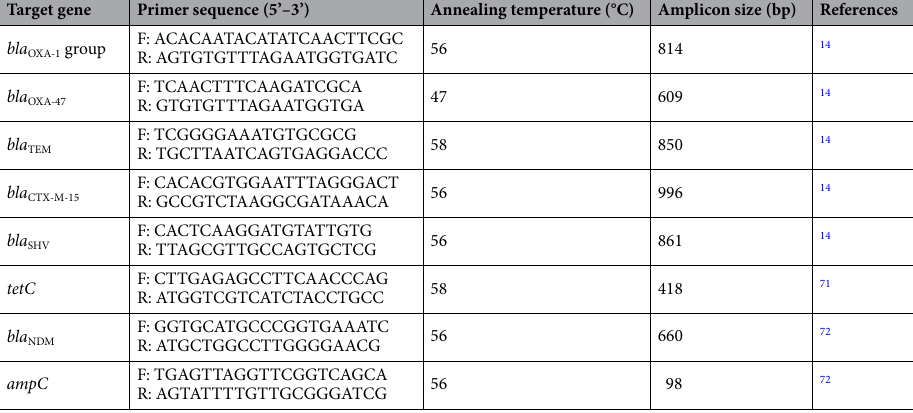
Table 5. Primers and PCR conditions for amplification of AMR